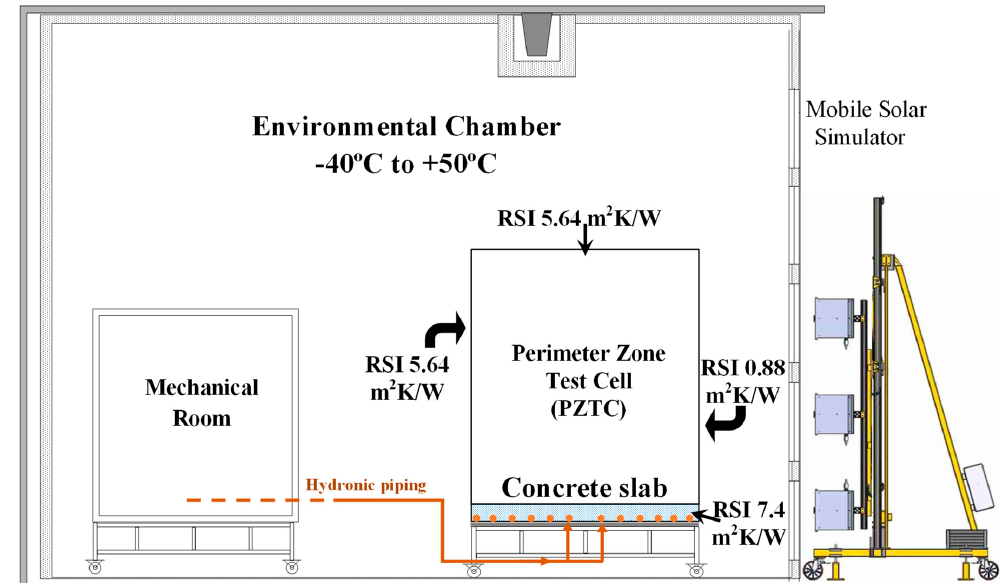
Figure 4. Schematic of Solar Simulator-Environmental Chamber (SSEC) with Perimeter Zone Test Cell (PZTC) and radiant floor.